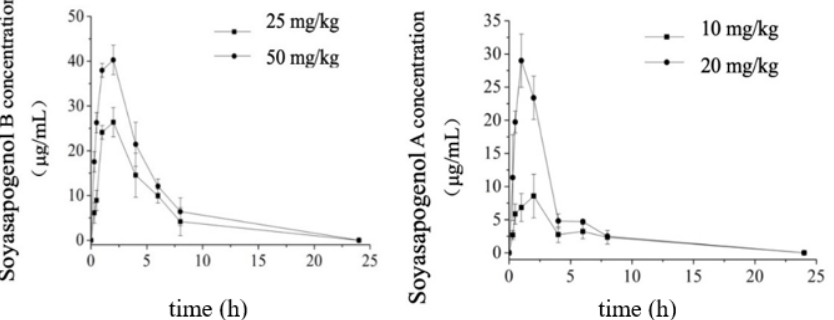
Figure 3. Plasma concentration–time curve of soyasapogenol after different dosages of oral administration. Left panel, soyasapogenol A: 10 and 20 mg/kg body weight (BW). Right panel, soyasapogenol B: 25 and 50 mg/kg BW. Values are mean ± SE; n = 6.